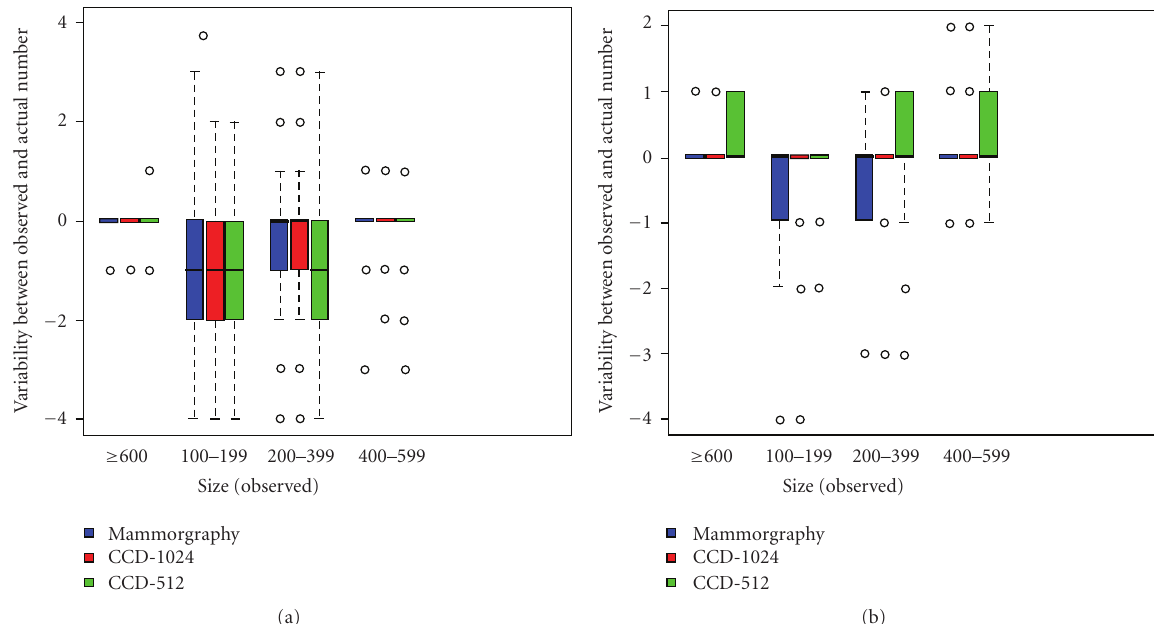
Figure 3: (a) Box plot presenting the interrater variability of the 4 radiologists’ from the experimentally preset gold standard as a function of size and number of simulated microcalcifications scattered on the 48 films. Statistical outliers are labeled with an asterisk ( ∗ ) or a dot ( • ). Criterion: “Number” of detectable microcalcifications as a function of the experimentally preset size of silica beads. (b) Box plot presenting the interrater variability of the 4 radiologists’ from an experimentally preset gold standard as a function of size and number of simulated microcalcifications scattered on the 48 films. Statistical outliers are labeled with an asterisk ( ∗ ) or dots ( • ). Criterion: “Size” of detectable microcalcifications as a function of the experimentally preset size of the silica